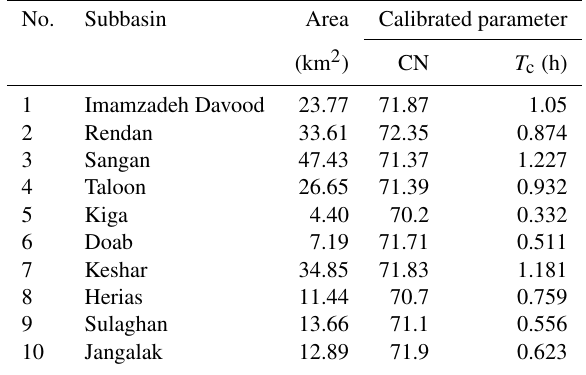
Table 2. The calibrated parameters for the HEC-HMS hydrologic